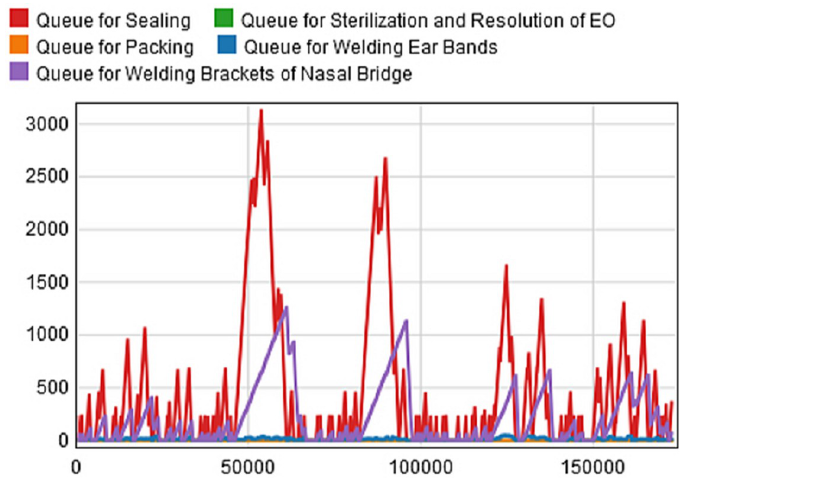
Fig 10. Model 5 staging area